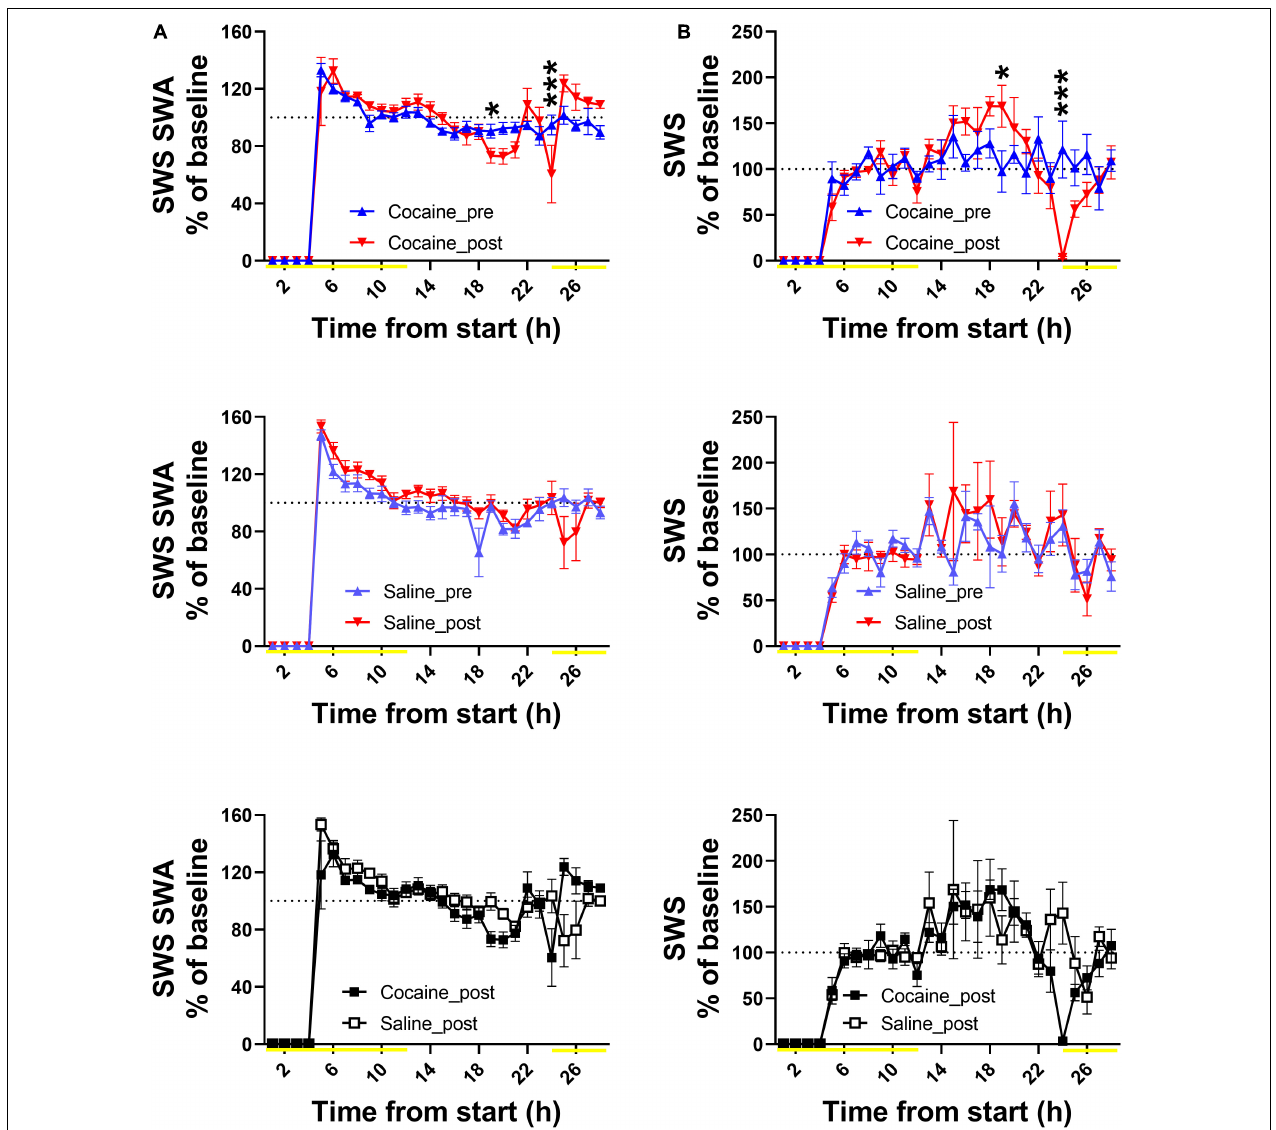
FIGURE 7 | Both cocaine- and saline-treated animals showed similar SWS SWA (A) and SWS time (B) response to a 4 h sleep deprivation challenge. The time course of SWS SWA% baseline and SWS time% baseline was modified by cocaine exposure as compared to response to the same 4 h SD challenge prior to the initial cocaine exposure. Saline induced a non-significant trend toward a change in the time course of SWS SWA% baseline while SWS time% baseline was unchanged compared to the response prior to the initial saline exposure. The cocaine-induced change in SWS SWA% baseline time course was also observed when comparing between cocaine- and saline-treated animals, while the change in SWS time% baseline became a non-significant trend toward a difference. Note the post data in panels (A,B) top and middle graphs is replotted in the bottom between-groups comparison graph. Data was plotted for 28 h to include the 4 h SD period followed by response over the next 24 h. Yellow lines indicate light phase, dashed lines at 100 indicate baseline levels, and asterisks above symbols indicate difference between conditions at those specific timepoints. Cocaine n = 6, saline n = 5. P and F values are given in Table 1 and statistics for all pairwise comparisons with significant difference or trends toward significance are given in Supplementary Table 7